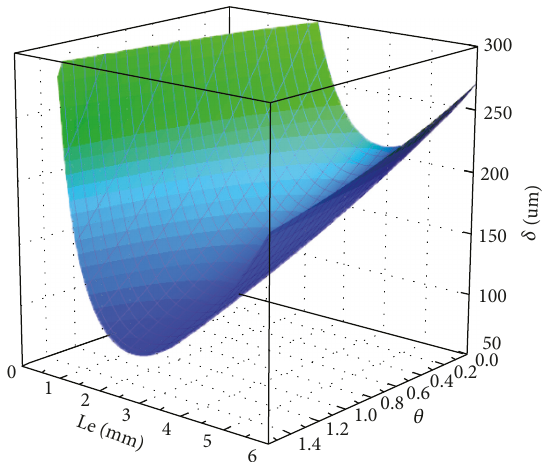
changes from 0.8 to 8 MPa, the L d ( θ ) Figure 10. When τ 0 and L p ( θ ) curves significantly shift down, as shown in Figure 10(a), which means the potential rupture space